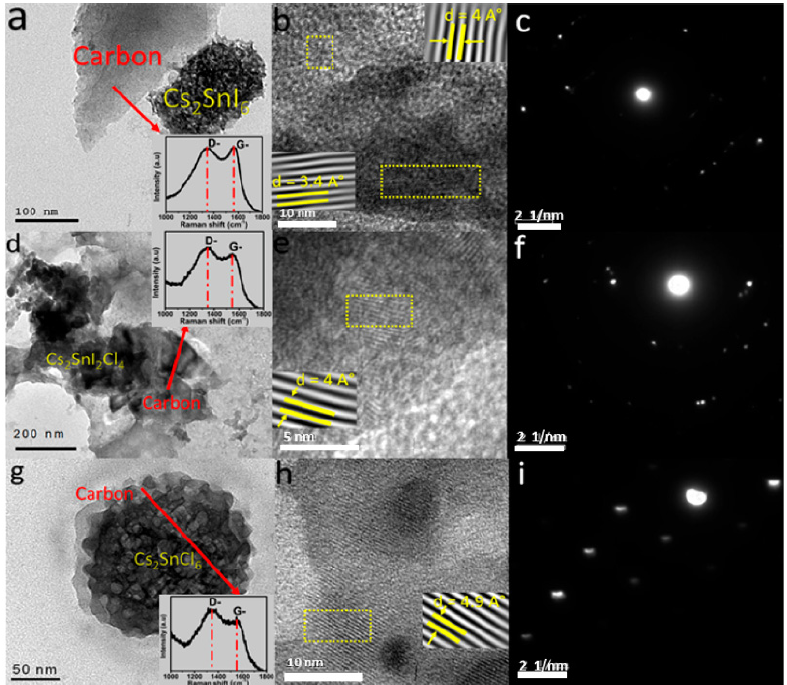
Figure 3. Examples of recent developments toward photovoltaic energy harvesting materials and structures for textile application: image by high-resolution transmission electron microscopy of double perovskites after annealing: Cs 2 SnI 6 ( a - c ), Cs 2 SnI 2 Cl 4 ( d - f ), Cs 2 SnCl 6 ( g - i ), with Raman spectra of the graphene oxide nanoparticles formed shown in inserts in a, d, and e (reproduced from [62], with permission from ACS Publications).